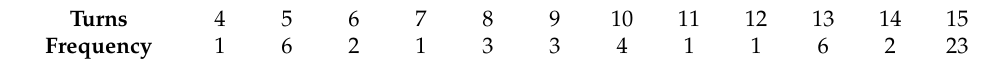
Table 1. The amount of turn made by the participants until the end of the simulation. Turns